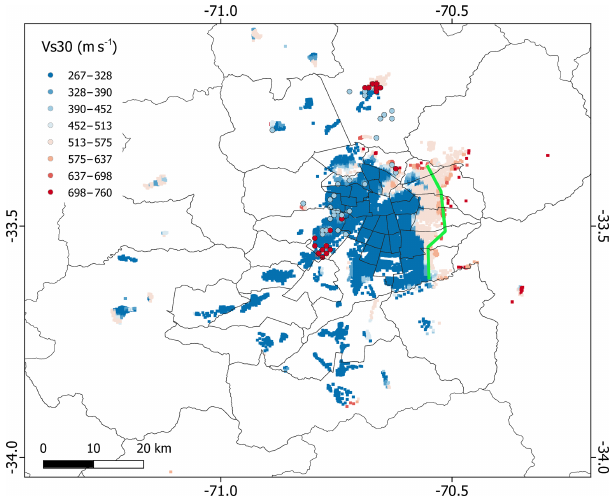
Figure 8. A map of the Vs30: shear-wave velocity in the top 30m of soil in metres per second at the exposure locations. The circled data are from microzonation studies (Leyton et al., 2011; Humire- Guarachi, 2013), and the remaining are estimates derived from the topographic slope (Allen and Wald, 2007). The green lines indicate the surface trace of the San Ramón Fault used in the seismic-risk- scenario calculations. Red colours indicate a relatively high Vs30 value and are generally in regions with exposed or shallow bedrock. Relatively slow Vs30 values are associated with sedimentary